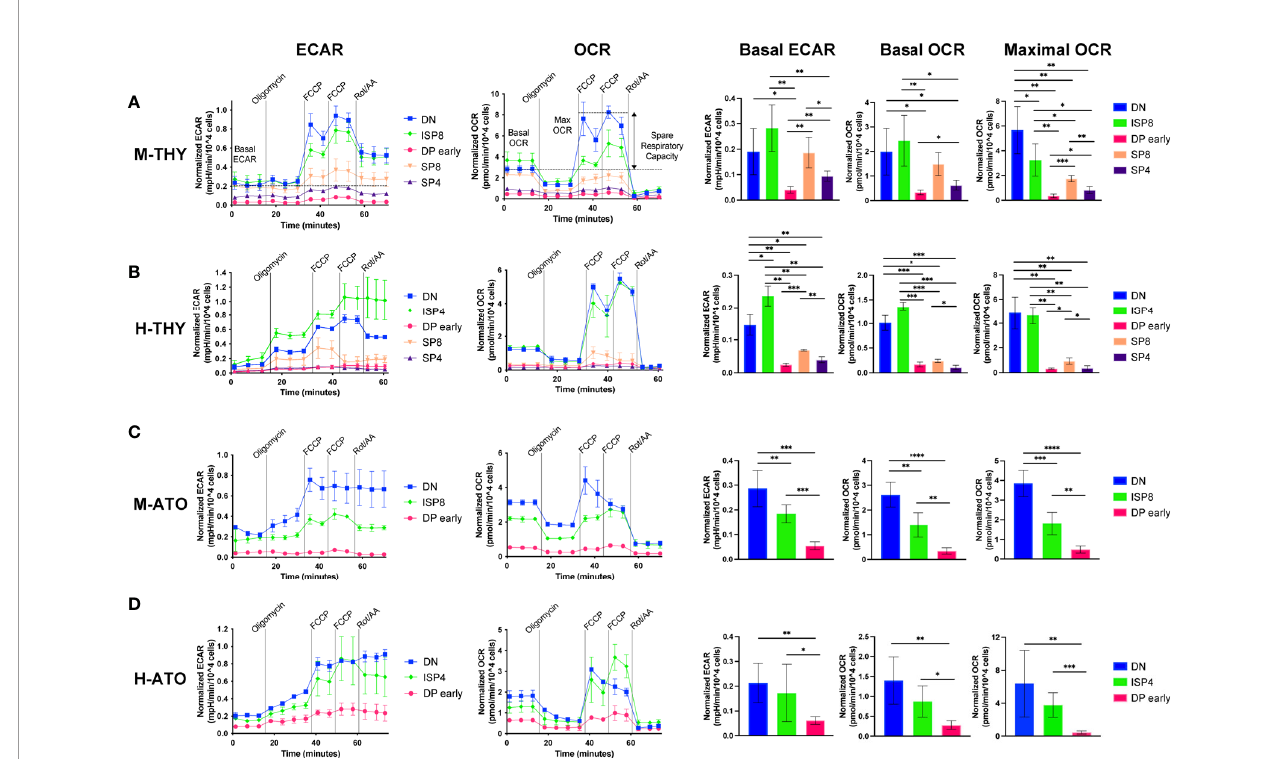
FIGURE 4 | (A – D) Extracellular fl ux analyses of thymocyte populations in (A) M-THY, (B) M-ATO, (C) H-THY, and (D) H-ATO. ECAR (left) and OCR (right) measurements are displayed for each time point over the course of several pharmacologic agents: oligomycin, FCCP, and Rotenone/Antimycin (Rot/AA). Line plots on the left show one representative experiment out of n=6 independent experiments in M-THY; n=6 M-ATO; n=3 H-THY (except for ISP4: n=2); n=6 H-ATO (except for ISP4: n=5). Symbols and error bars represent mean +/- sd for 2-4 technical replicates (wells). Measurements are normalized to cell number per well. The bar graphs on the right consist of aggregated data from all experiments. Basal ECAR, basal OCR, and maximal OCR for each population were calculated as detailed in the methods and compared. (error bars: sd, signi fi cance: multiple t-test p values *p < 0.05; **p < 0.01, ***P < 0.001, ****P <